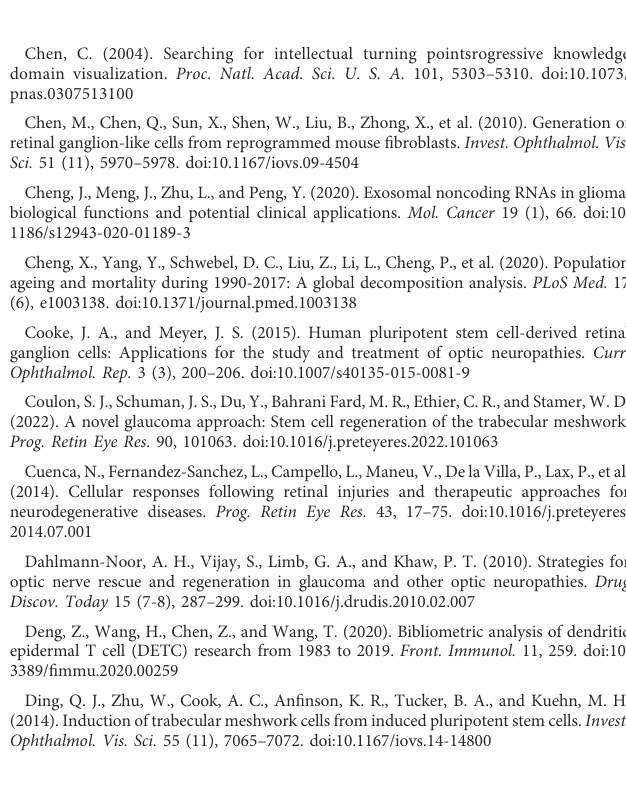
SUPPLEMENTARY FIGURE S1 The cooperative relationship between authors. (A) The co-authorship network visualization map of authors related to work on applications of stem cells for glaucoma. The authors were clustered into 3groups according to their color. Large nodes represent proli fi c authors. (B) In the overlay visualization map betweenauthors,theweightisthenumberofpublications,andthecoloristhe average publication year. Blue represents the early stage, and yellow represents the late stage. SUPPLEMENTARY FIGURE S2 The cluster analysis of the highly cited